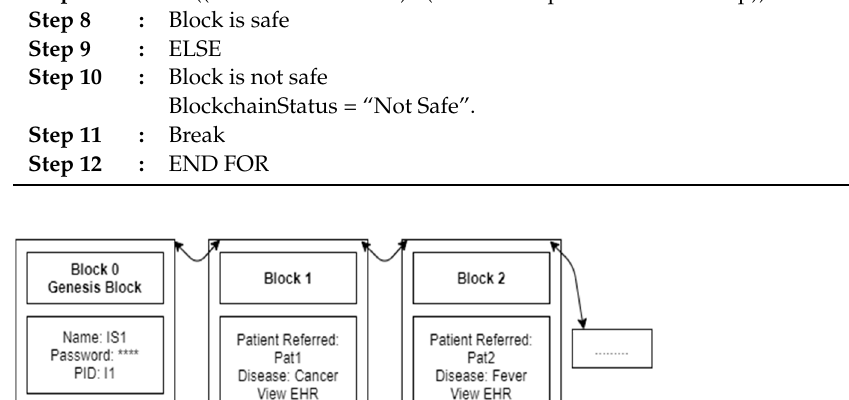
Figure 3. Doctor Doc1 blockchain.